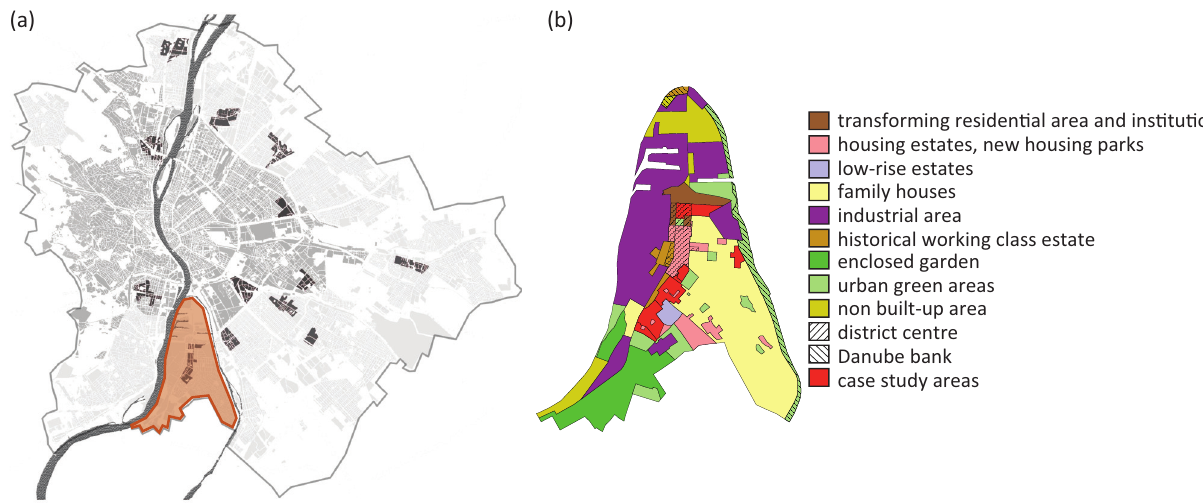
Figure 1. Csepel: (a) Location of District 21 and (b) land use in Csepel. Source: Authors’ work based on Csepel Budapest (2017).